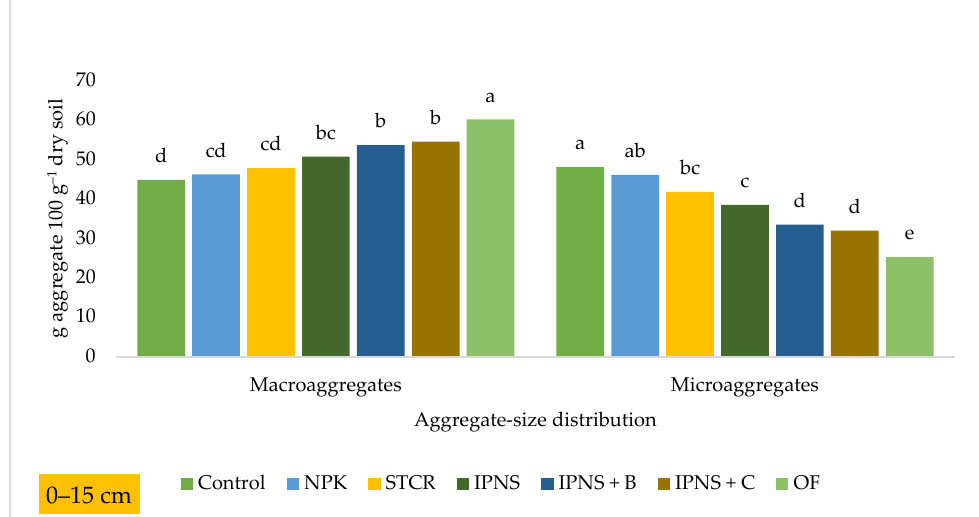
Figure 5. Effect of long-term nutrient supply options on macroaggregate and microaggregate frac- tions in the 0–15 cm soil layer of a rice–wheat cropping system. Means of different treatments followed by the different lower-case letters are significantly different at p < 0.05 level of significance according to DMRT.